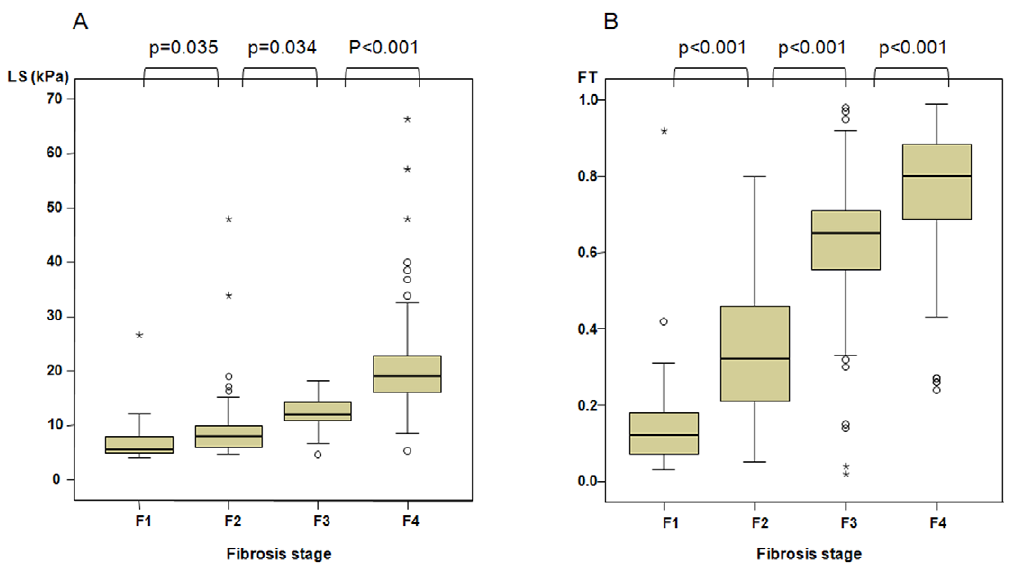
Figure 2. Box plots of LS (A) and FT (B) according to fibrosis stage. Boxes and horizontal lines within boxes represent interquartile ranges (IQRs) and median values, respectively. The upper and lower whiskers indicate 75 th percentile plus 1.5 IQR and 25 th percentile minus 1.5 IQR, respectively. o, mild outlier: a value more than 75 th percentile plus 1.5 IQR, but less than 75 th percentile plus 3.0 IQR. *, extreme outlier: a value more than 75 th percentile plus 3 IQR.